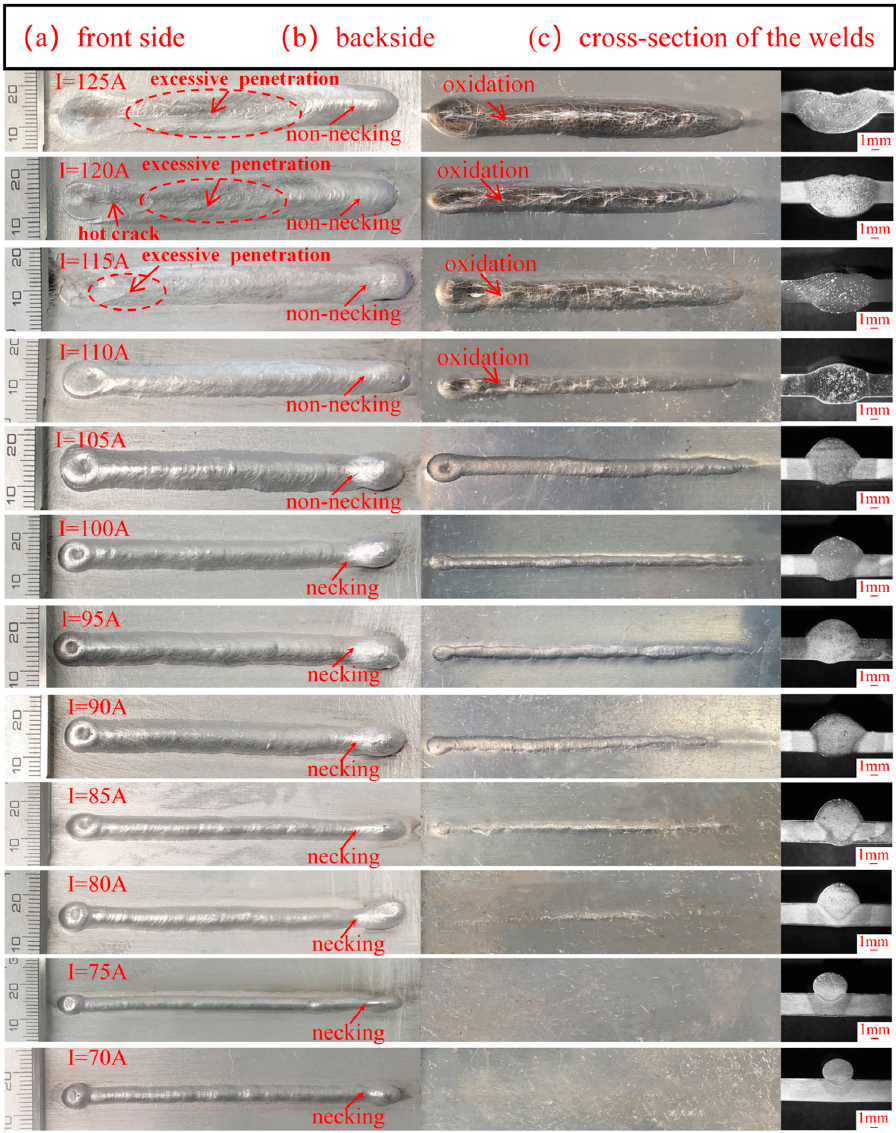
Figure 3. Appearance and cross-sectional shape of weld seam under different heat inputs.